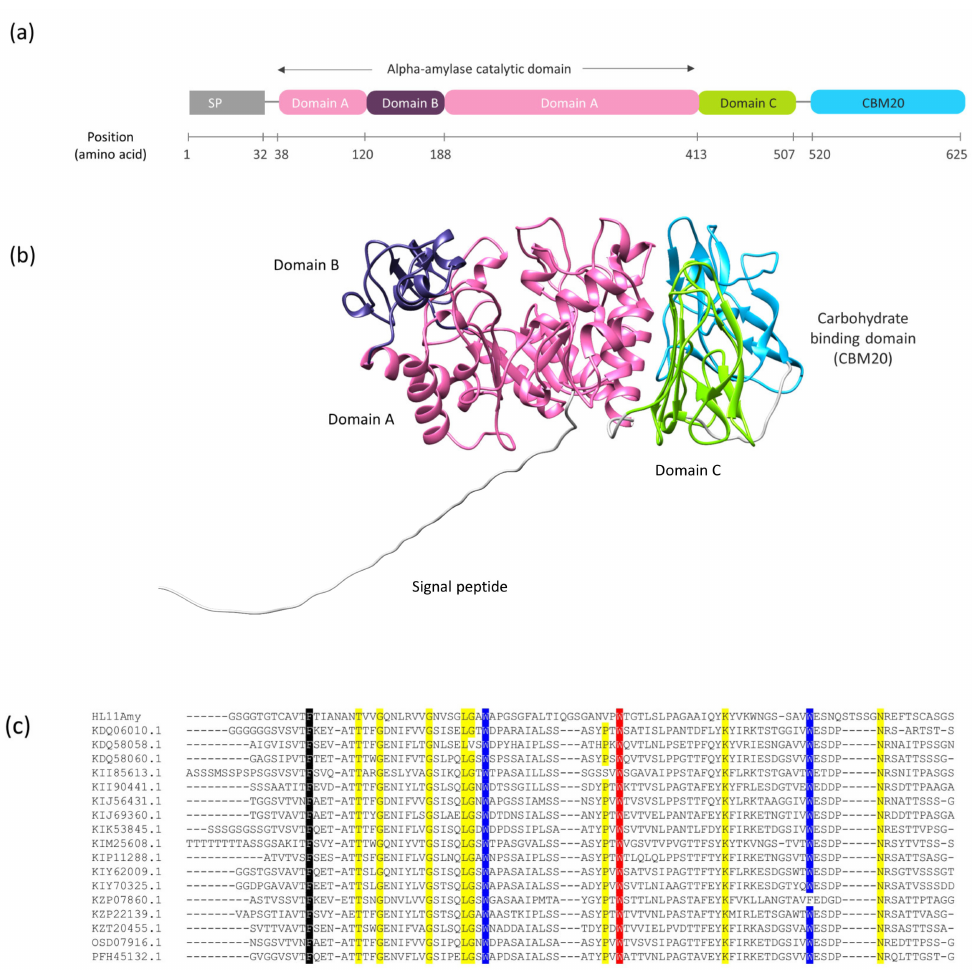
Figure 2. Domain organization and overall structure of HL11Amy. ( a ) Schematic representation of domain organization in HL11Amy. ( b ) The predicted three-dimensional structure of HL11Amy from R . terrae HL11. ( c ) Sequence alignment of CBM20 in HL11Amy and α -amylases in GH13_32. The 11 conserved amino acid residues in CBM20 based on [29,30] are highlighted. Two tryptophans of binding site 1 and one tryptophan of binding site 2 are highlighted in blue and red, respectively. The remaining eight residues are highlighted in yellow. The additional well-conserved phenylalanine in CBM20 is in black. The list of proteins is given in Table